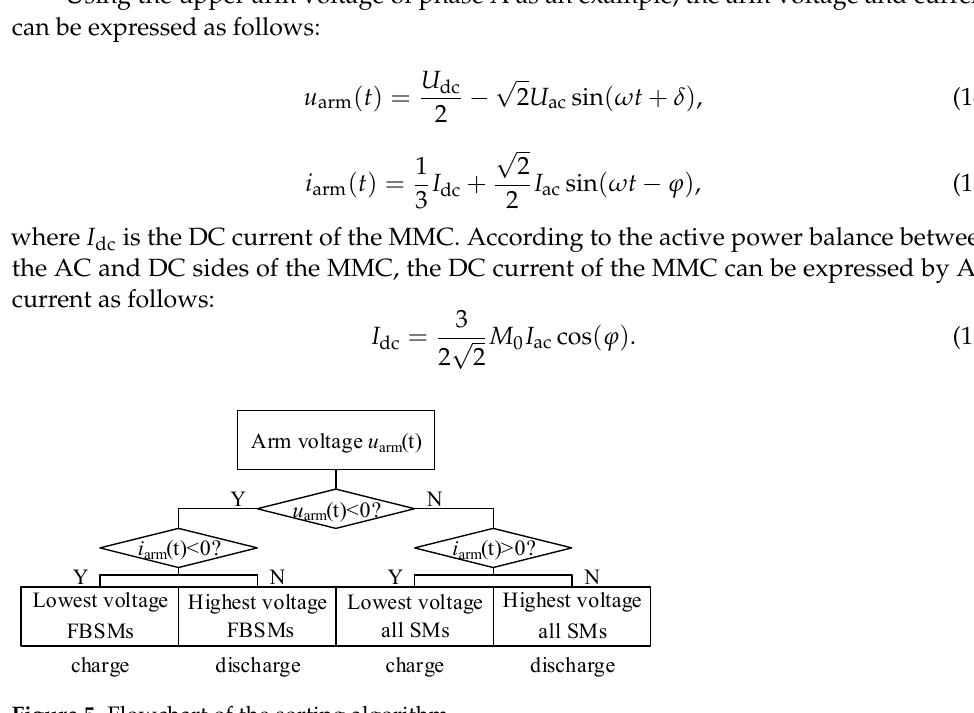
Figure 5. Flowchart of the sorting algorithm.